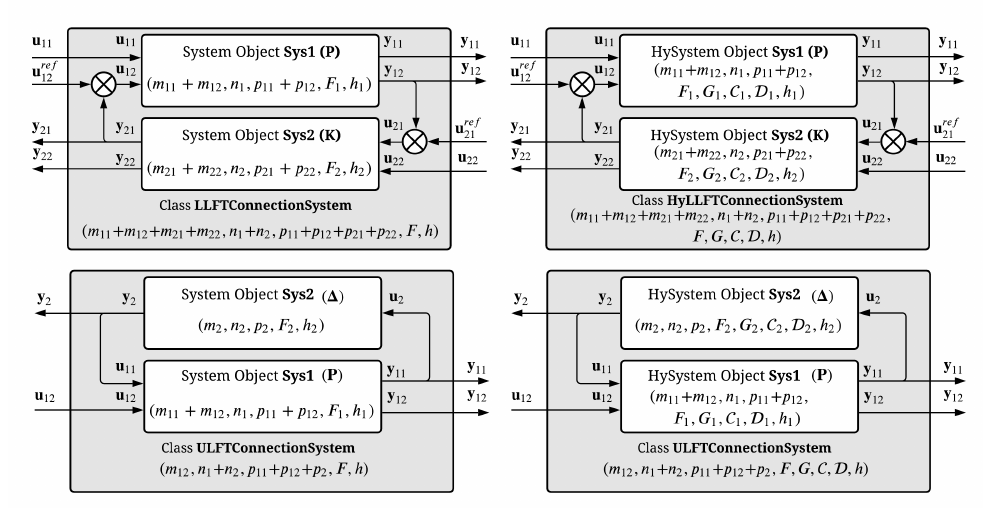
Figure 3. Upper (ULFT) and lower (LLFT) linear fractional transformation interconnections for general-purpose nonlinear and hybrid systems, with the ability to impose external reference